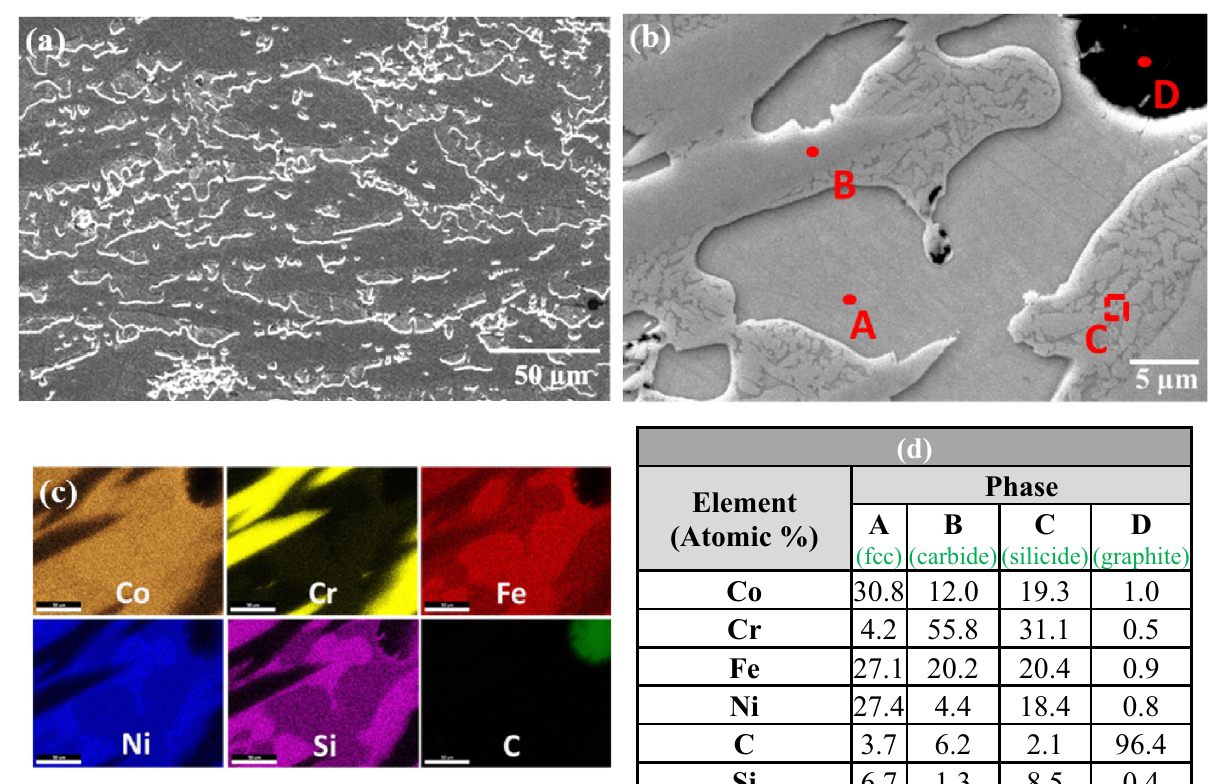
Figure 5. ( a ) SEM image of sample S-4, ( b ) magnified view, ( c ) elemental mapping, and ( d ) EDS results at the indicated